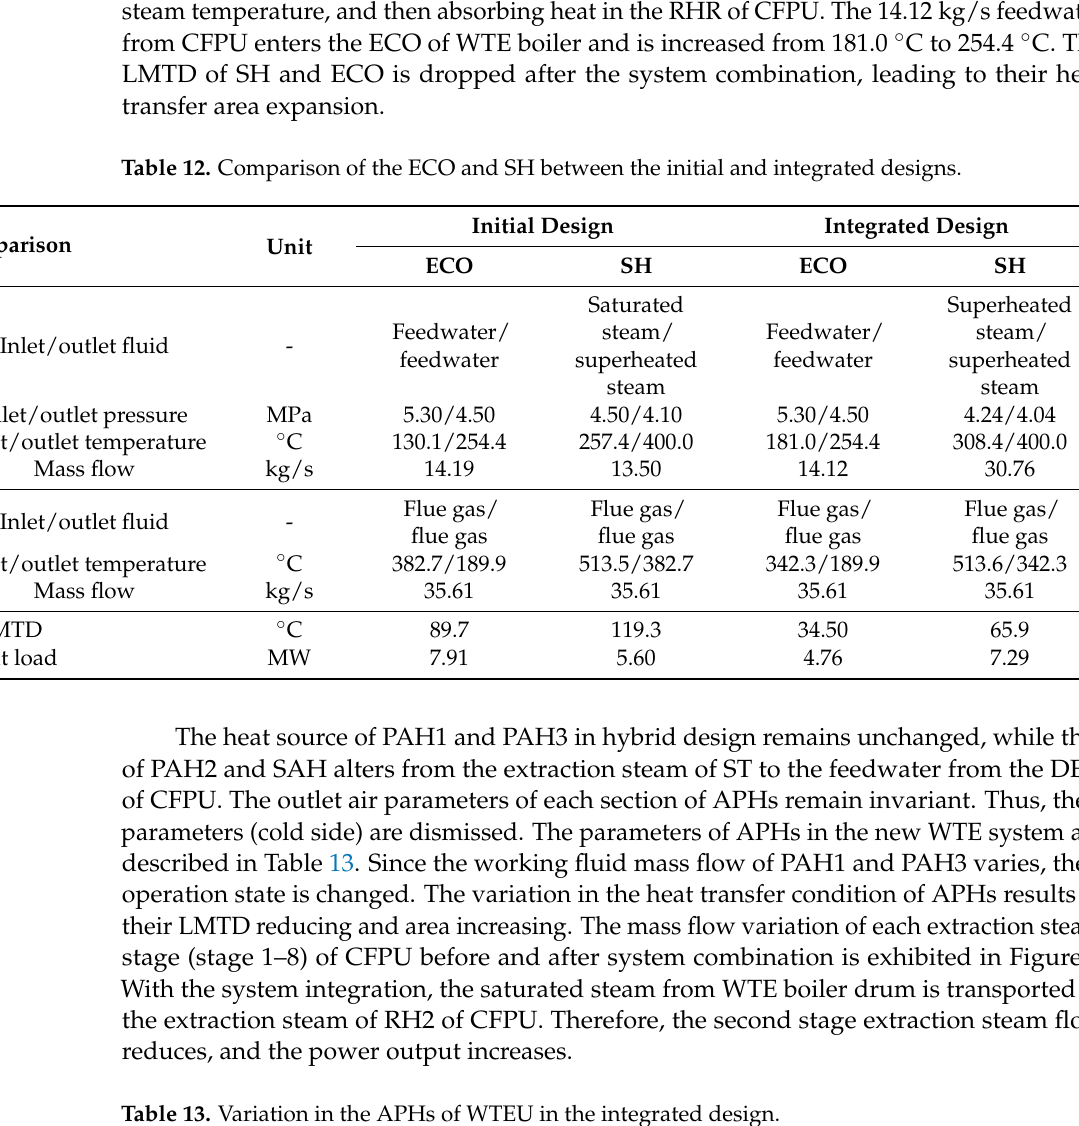
Table 13. Variation in the APHs of WTEU in the integrated